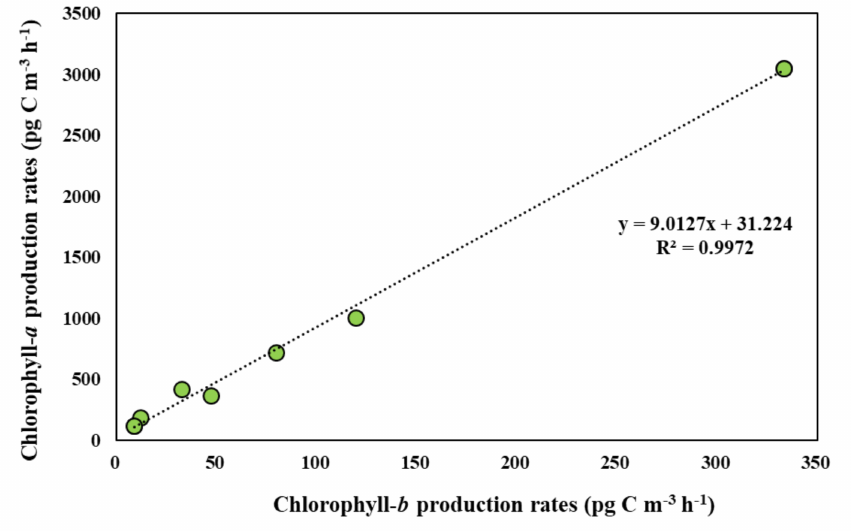
Figure 6. The correlation between the production rates of chlorophyll- b and chlorophyll- a at the surface layer of the YS and